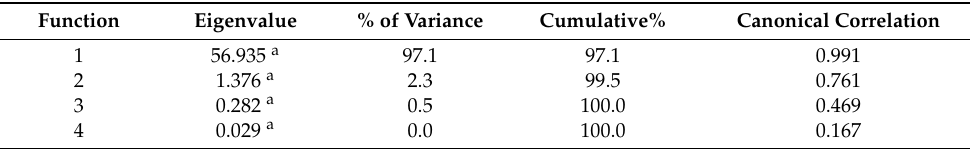
Table 1. The table of the Eigenvalues of each